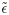
Random mutation model.A. Time average of population-averaged lag time of the random mutation model (Eq. 5 in S1 Text) for two choices of the mutation rate (ϵ˜, see S1 Text section 3). B The population-averaged lag time with one standard deviation of each round (from 104th to 1:1 × 104th round) for several p values. Data points are plotted every 10 rounds. Error bar indicates the standard deviation. The black dashed line representing the optimal lag time obtained from the optimization of FI is added for each panel if the optimal lag time is non-zero (p = 0.3; 0.4 and 1.0). N = 200; Δλ = 0.1, T = 6.0 and γ = 1.0. ϵ˜=10−4 for B.